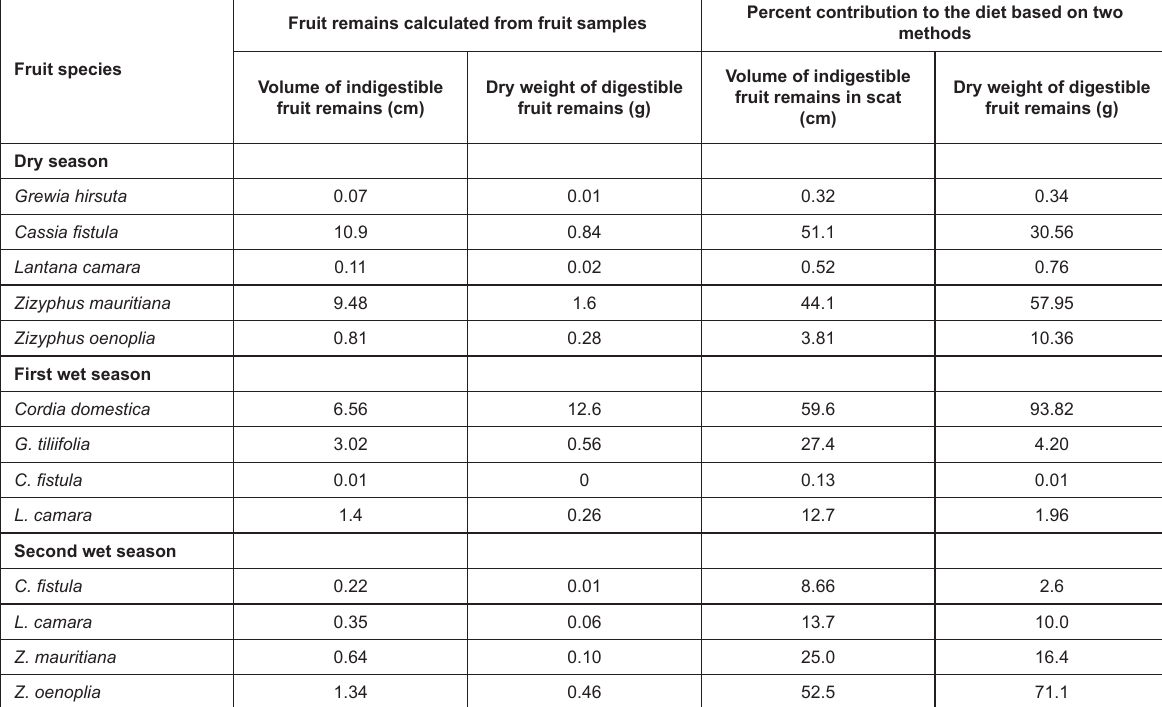
Table 1. Estimating the contribution of fruits of different plant species to the diet of Sloth Bears using the percent volume of seeds (indigestible items) in the scats and the percent dry weight of digestible fruit pulp (estimated from seed volume). For this analysis, the contribution of these food species is treated as 100% of the diet of the Sloth Bear